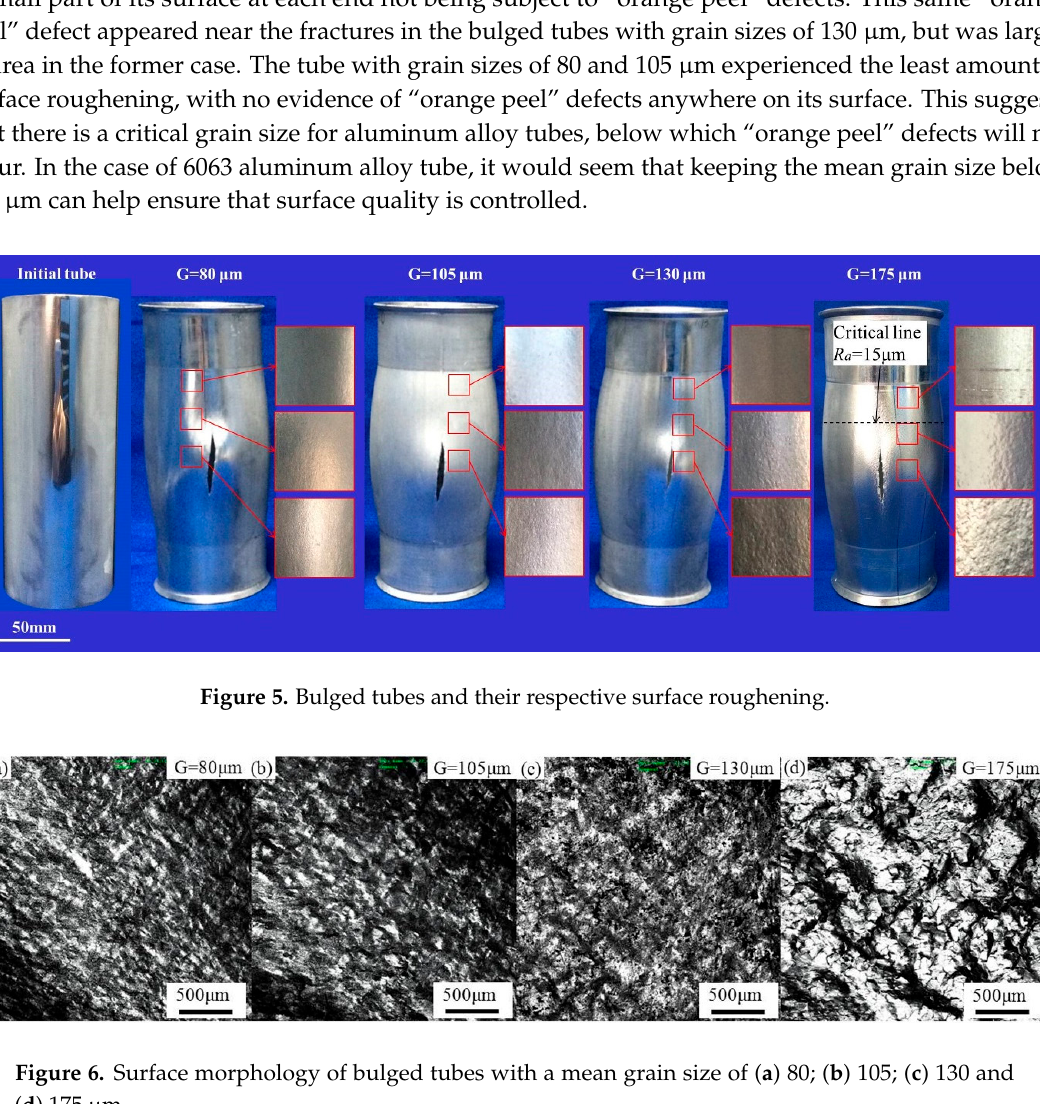
Figure 7. Effective strain distribution of bulged tubes with different grain sizes.